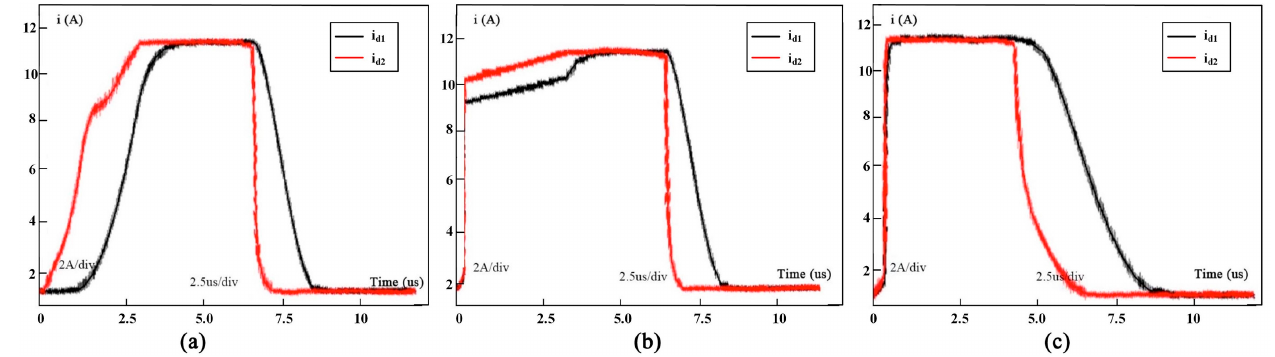
Figure 18. Double-pulse tests with multiple parasitic inductance parameters: ( a ) L g within the switching process; ( b ) L d within the switching process; and ( c ) L s within the switching process. The maximum L g is on DUT5, and the minimum L g is on DUT7. The maximum L d is on DUT3, and the minimum L g is on DUT5. The maximum L s is on DUT4, and the mini- mum L s is on DUT3. The maximum C gs is on DUT1, and the minimum L g is on DUT8. The parasitic parameters (L d , L g , L s , C gs , t d , V on , R on , and Δ T m ) are tested independently on the